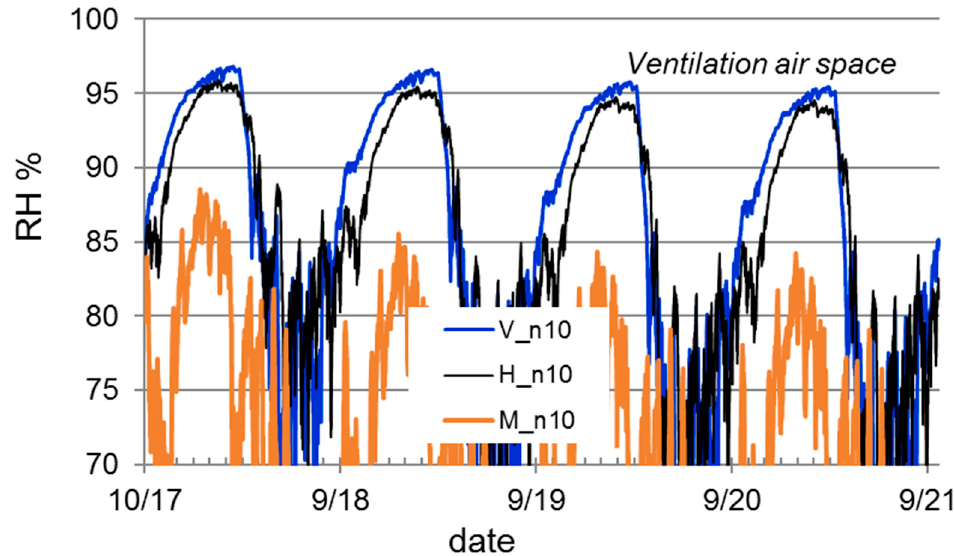
Figure 11. Brick wall, ventilation scheme 1, n = 10 1/h, normal dry initial conditions (80% RH). The solved relative humidity in the ventilation air space in three different climates during the four-year simulation period.